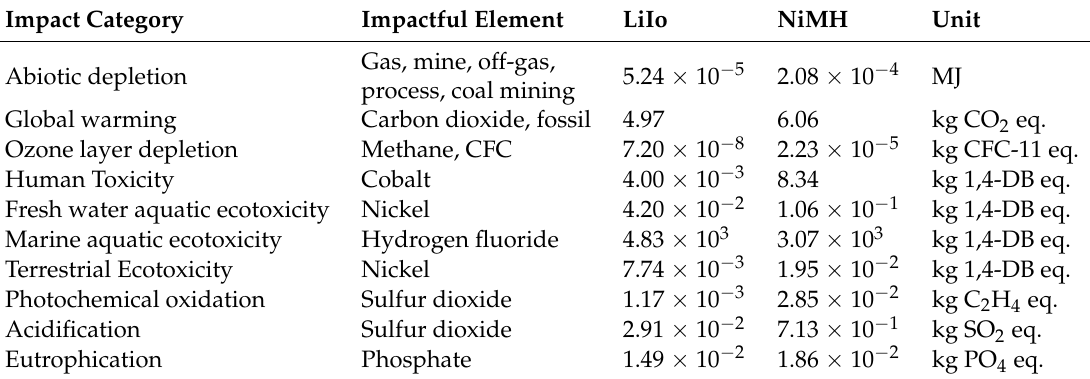
Table 8. Category-wise most impactful substances for 1 kg battery